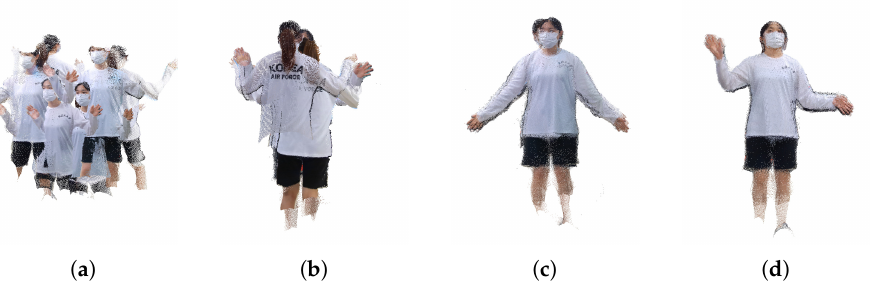
Figure 17. Generated point cloud (human #2) ( a ) before calibration, ( b ) after 18 frames, ( c ) after 73 frames, ( d ) 74